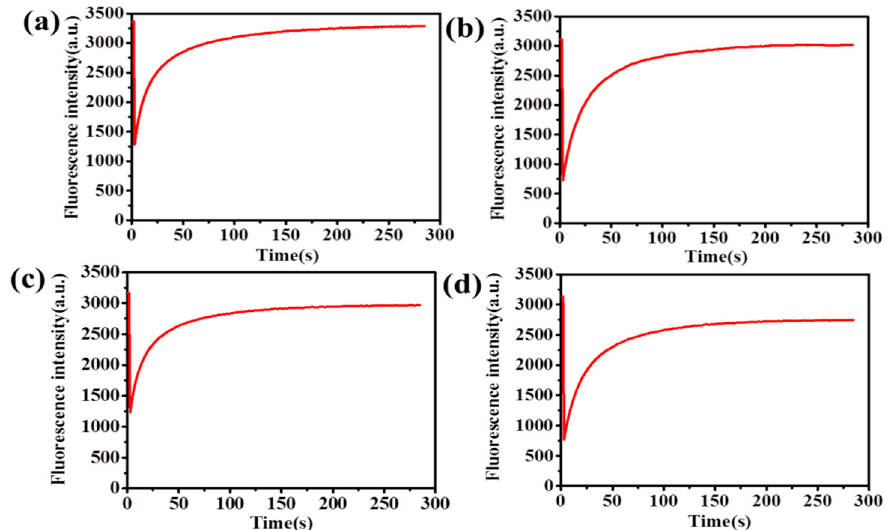
Figure 1. Schematic representations of the fluorescence recovery after photobleaching (FRAP) experiments on sodium fluorescein ( a ) the FRAP image of pure hyaluronic acid (HA) (3 wt.%); ( b ) the FRAP image of HA-CD (3 wt.%, grafting rate 4.71%); ( c ) the FRAP image of pure HA (4 wt.%); ( d ) the FRAP image of HA-CD (4 wt.%, grafting rate 4.71%).